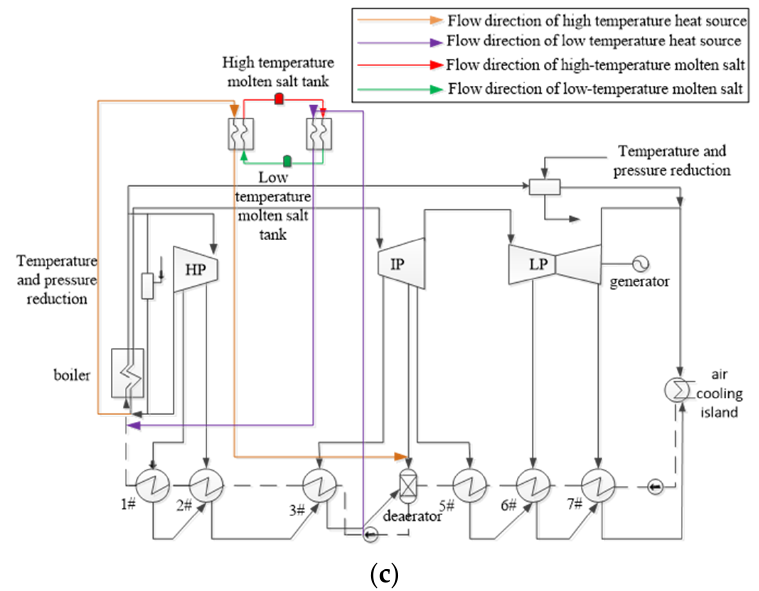
Figure 1. Unit-coupled heat-storage systems. ( a ) R1; ( b ) R2; ( c ) R3.